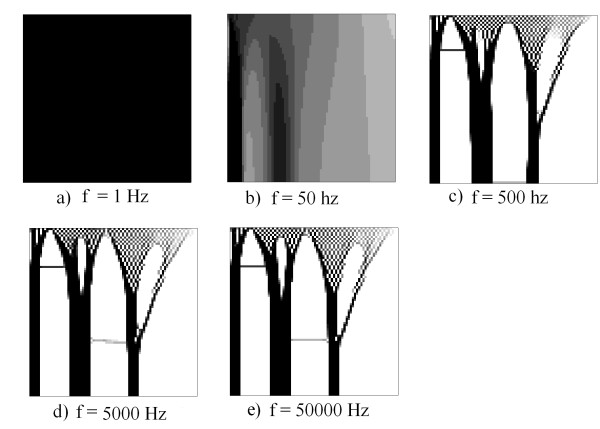
Results for the first example: the electric boundary condition in Figure7d. The figure demonstrates the results for various values ofkelect.